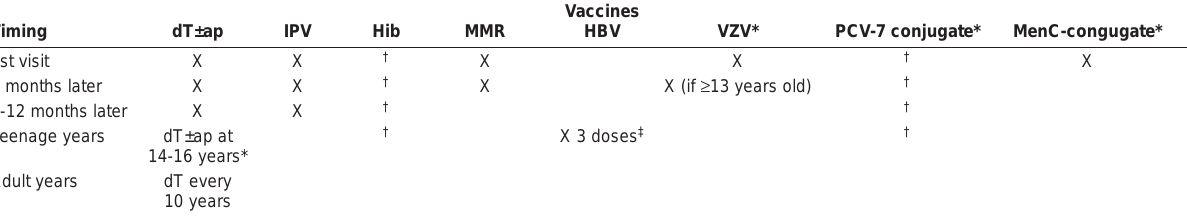
TABLE 3 Immunization schedule for children seven years of age and older not previously immunized in infancy (and still nonimmune)